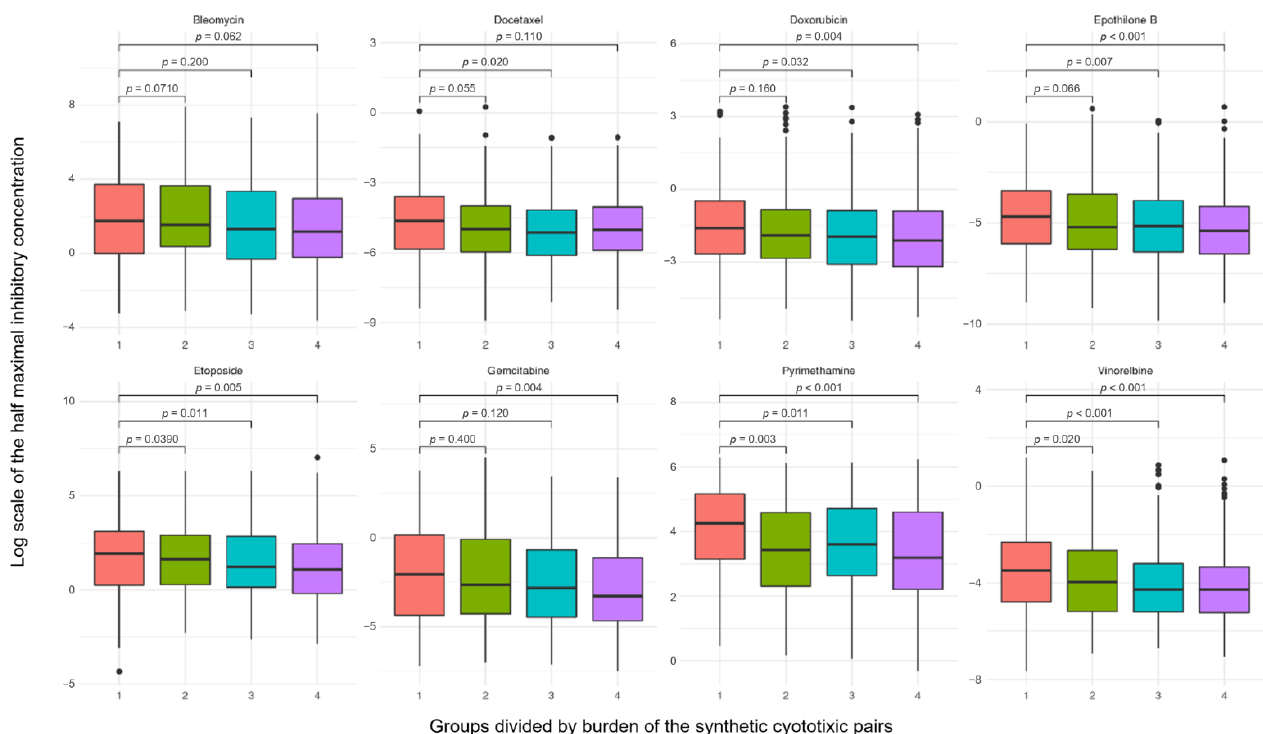
Figure 8. The four groups were divided according to the number of synthetic cytotoxic pairs. The burden of the synthetic cytotoxic pair can significantly differentiate the response to paclitaxel from that to other cytotoxic drugs.